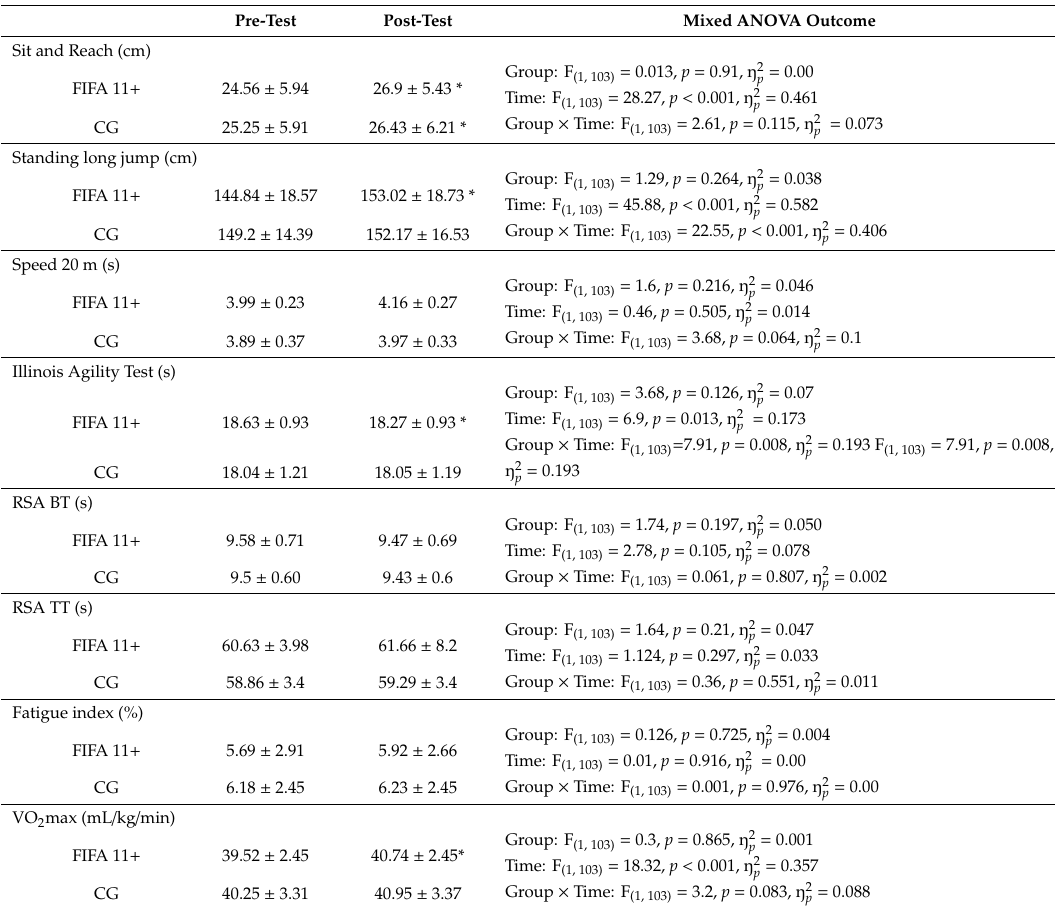
Table 2. Di ff erences between F é d é ration Internationale de Football Association (FIFA) 11 + (n = 19) and CG (n = 17) in physical performance measures from pre- to post-test. Pre-Test Post-Test Mixed ANOVA